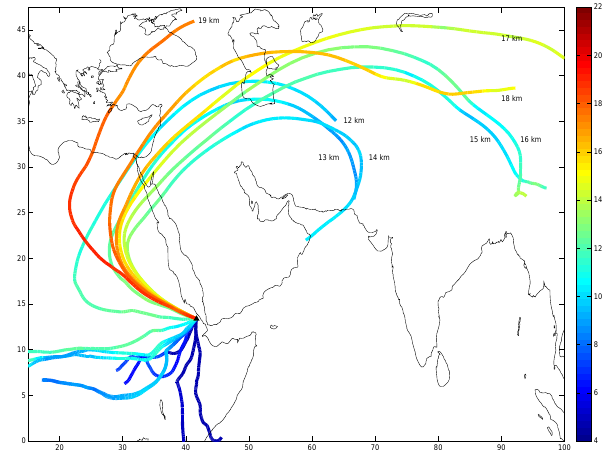
Fig. 5. HYSPLIT trajectories of an instantaneous injection from Nabro at 22:00UTC on 12 June 2011 with injection heights ranging from 3–19km for a period of 5days. The colours of the trajectories indicate the forecasted altitude, rather than the injected